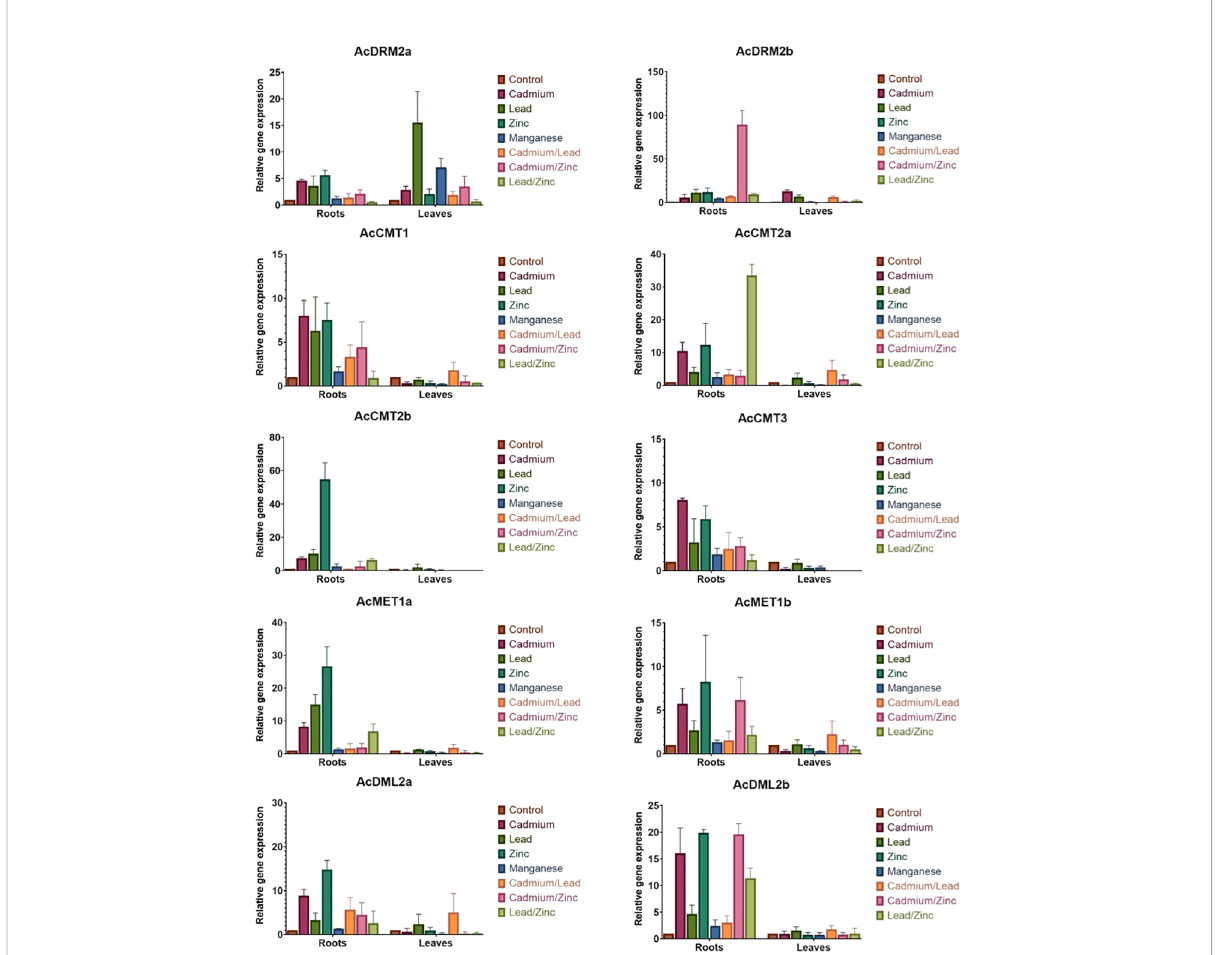
FIGURE 5 Relative expression of A. cruentus MTase and DMTase genes in root and leaf tissues under the individual and combined HM stress. Error bars indicate the mean ± SD (standard deviation) of three biological replicates.